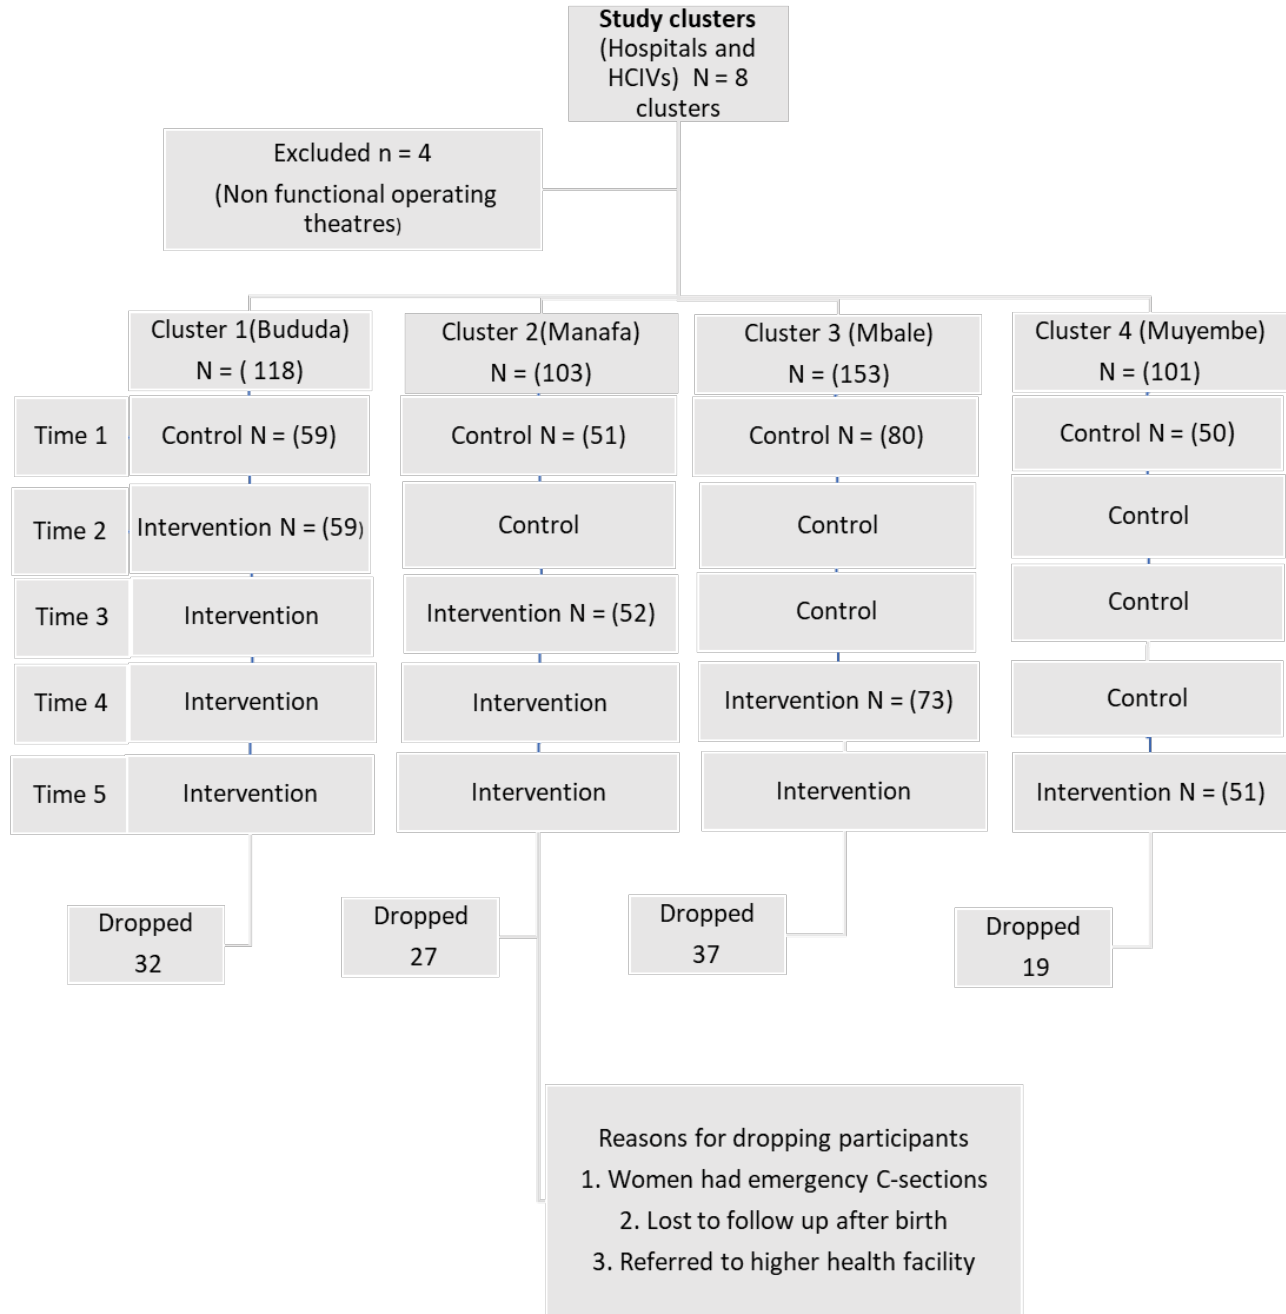
Figure 3. Trial flow chart.